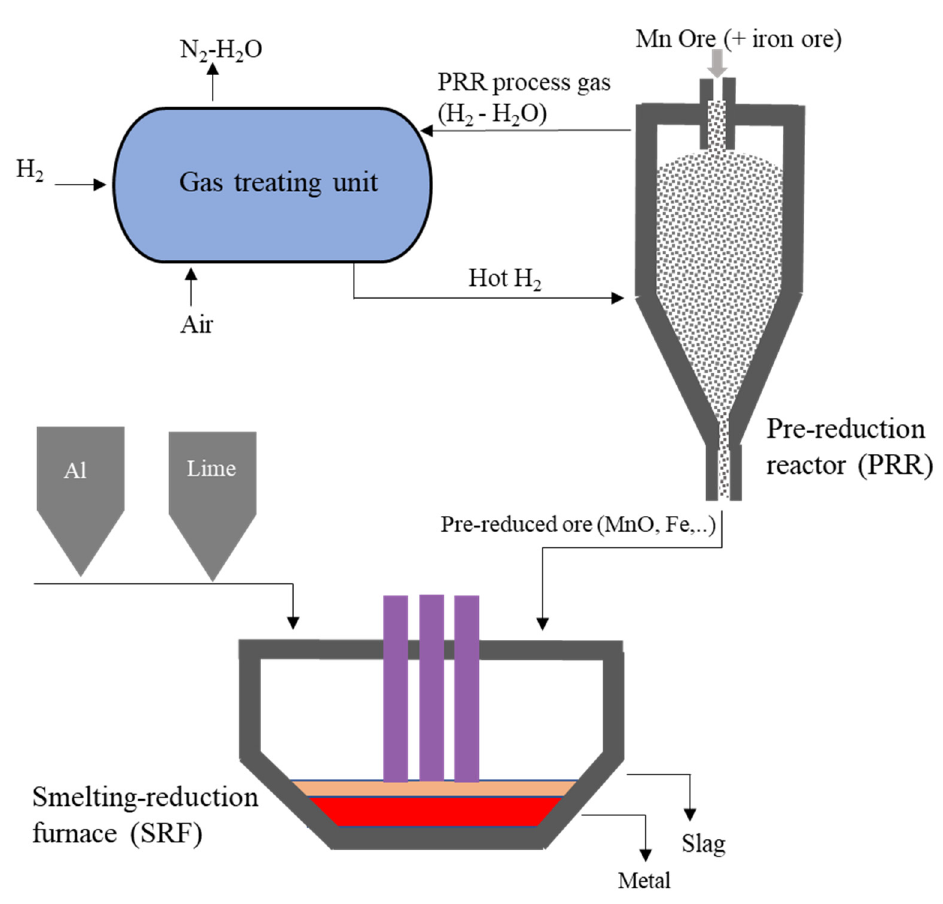
Figure 1. Schematic of the HAlMan process for sustainable production of metals using hydrogen and Al sources.